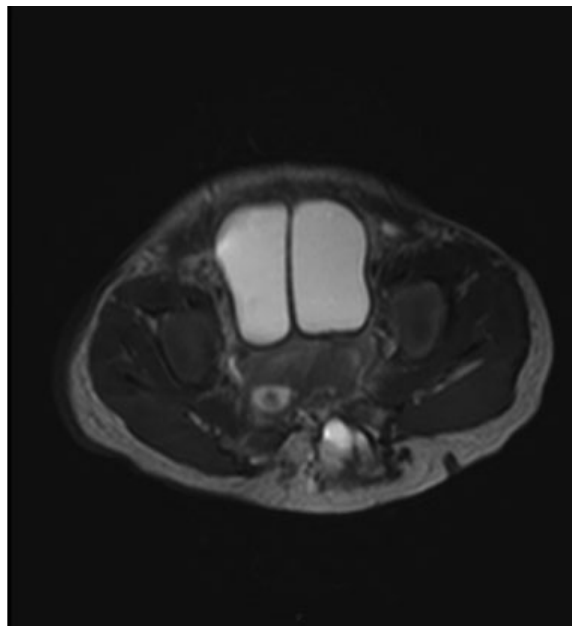
Fig. 4 MRI of abdomen showing the two hemibladders with a midline sagittal septum.